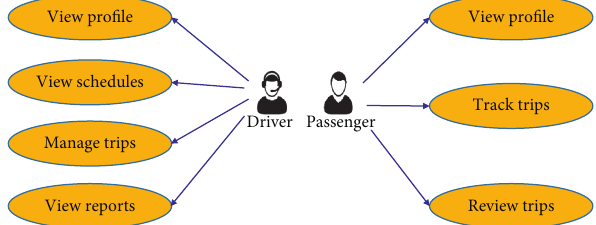
Figure 3: The use case diagram for the main features for the driver and passenger user